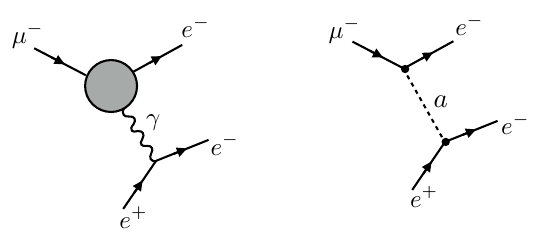
Figure 39 . Diagrams contributing to µ → 3 e